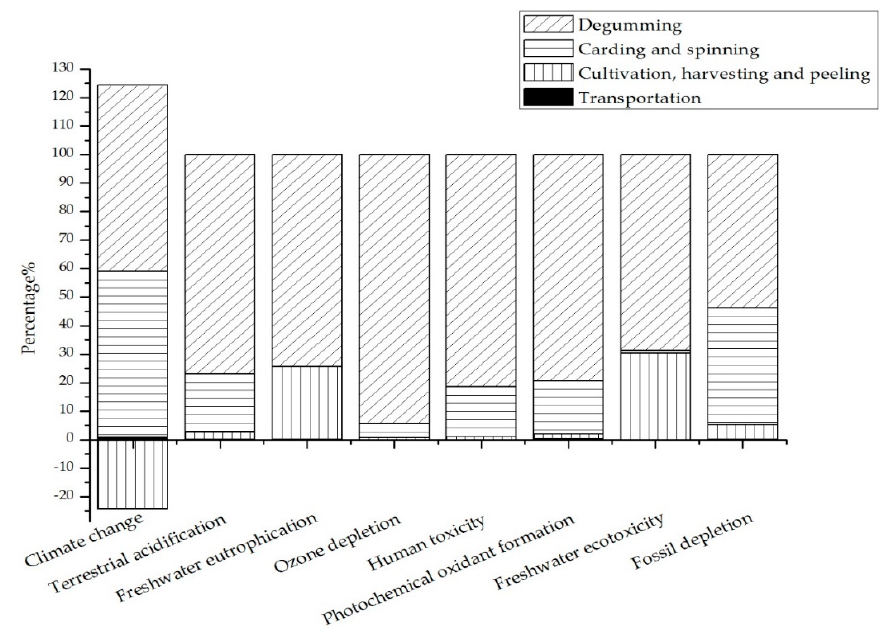
Figure 4. Percentages of different processes that contribute to the eight different environmental impact categories of ramie yarns.